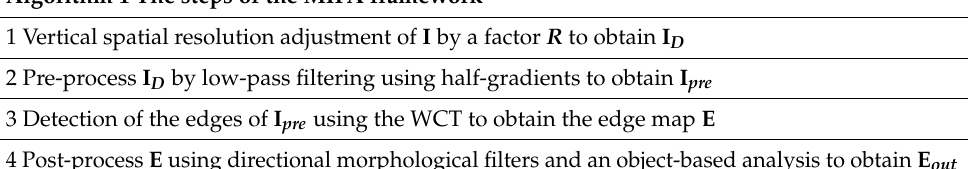
Algorithm 1 The steps of the MIPA